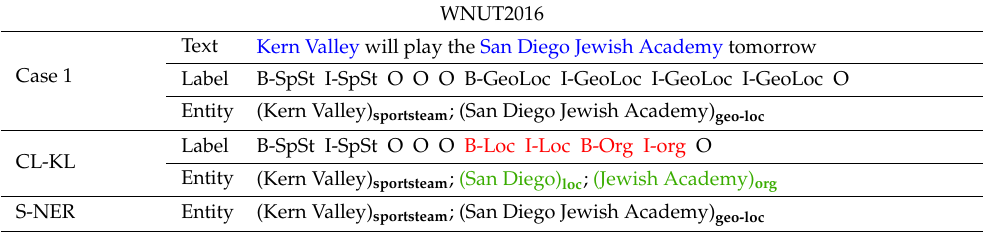
Table 9. Case study of the three benchmarks where the blue font denotes the gold entities located in sentences; the red font denotes cascading label misclassifications; and the green font denotes mistakenly predicted entities. In the three cases, all labels and entities in Case rows are gold, and all entities are correctly predicted by S-NER. Furthermore, the CL-KL, RDANER and Table-sequence are the previous best sequence labeling-based NER models on the three benchmarks,